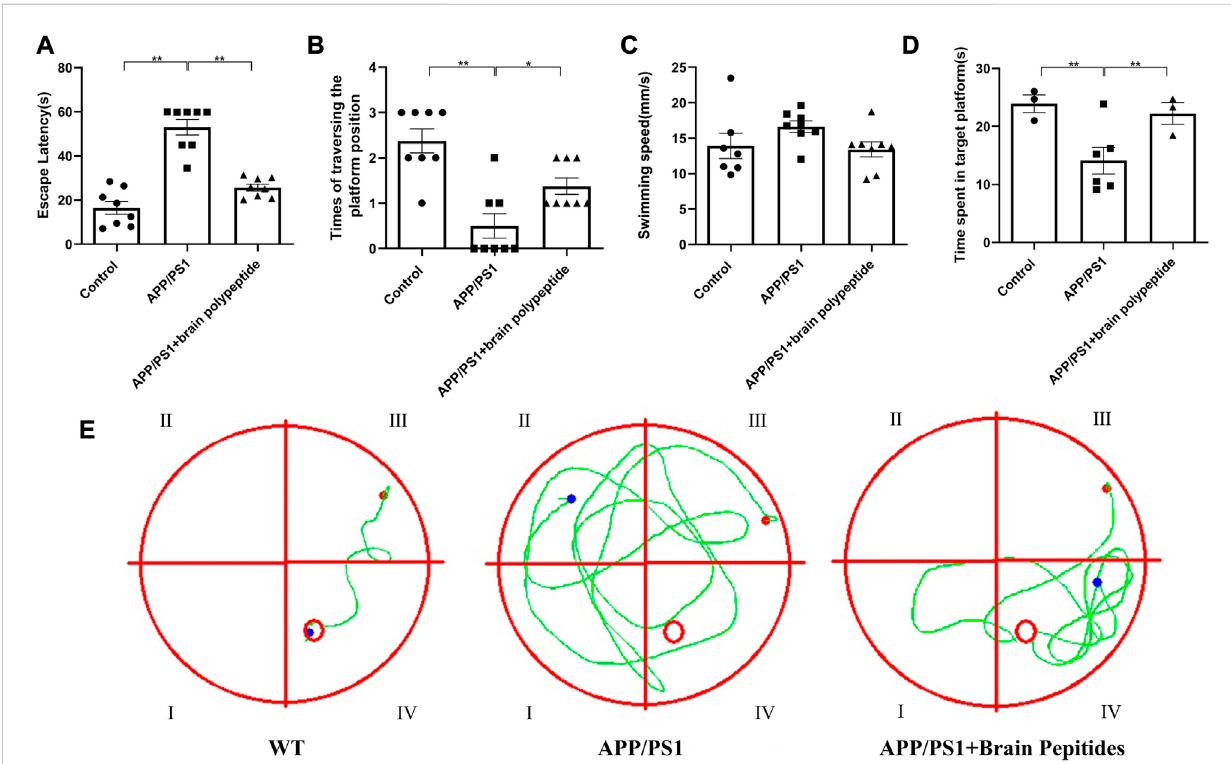
Cerebroprotein hydrolysate improves the learning and memory ability of APP/PS1 mice. (n = 8). Note: (A) escape latency of mice in each group; (B) number of times the mice traversed the platform in each group; (C) swimming speed of mice in each group; (D) number of times the mice entered the targetquadrantineachgroup; (E) swimmingtrajectoryofthemiceineachgroup.Thedataareexpressedasthemean±standarderrormean( (cid:1) x ± sem),as revealed by the one-way analysis of variance. * p < 0.05, ** p < 0.01.